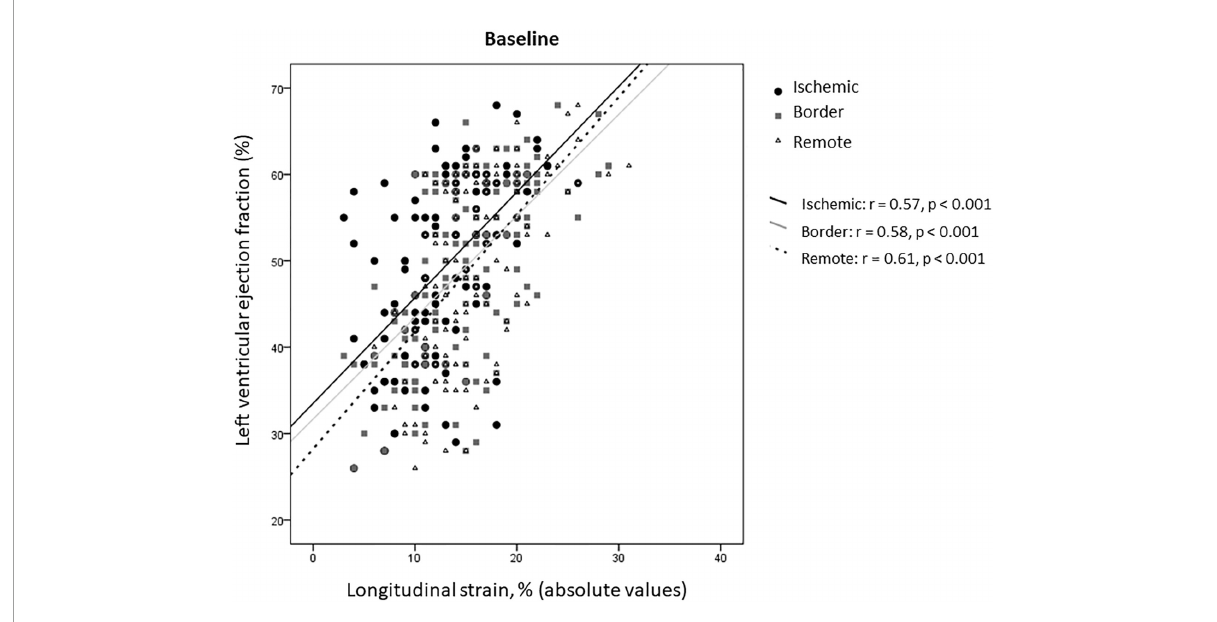
FIGURE3 Correlations between LS of ischemic, border, and remote myocardium and LVEF at baseline.